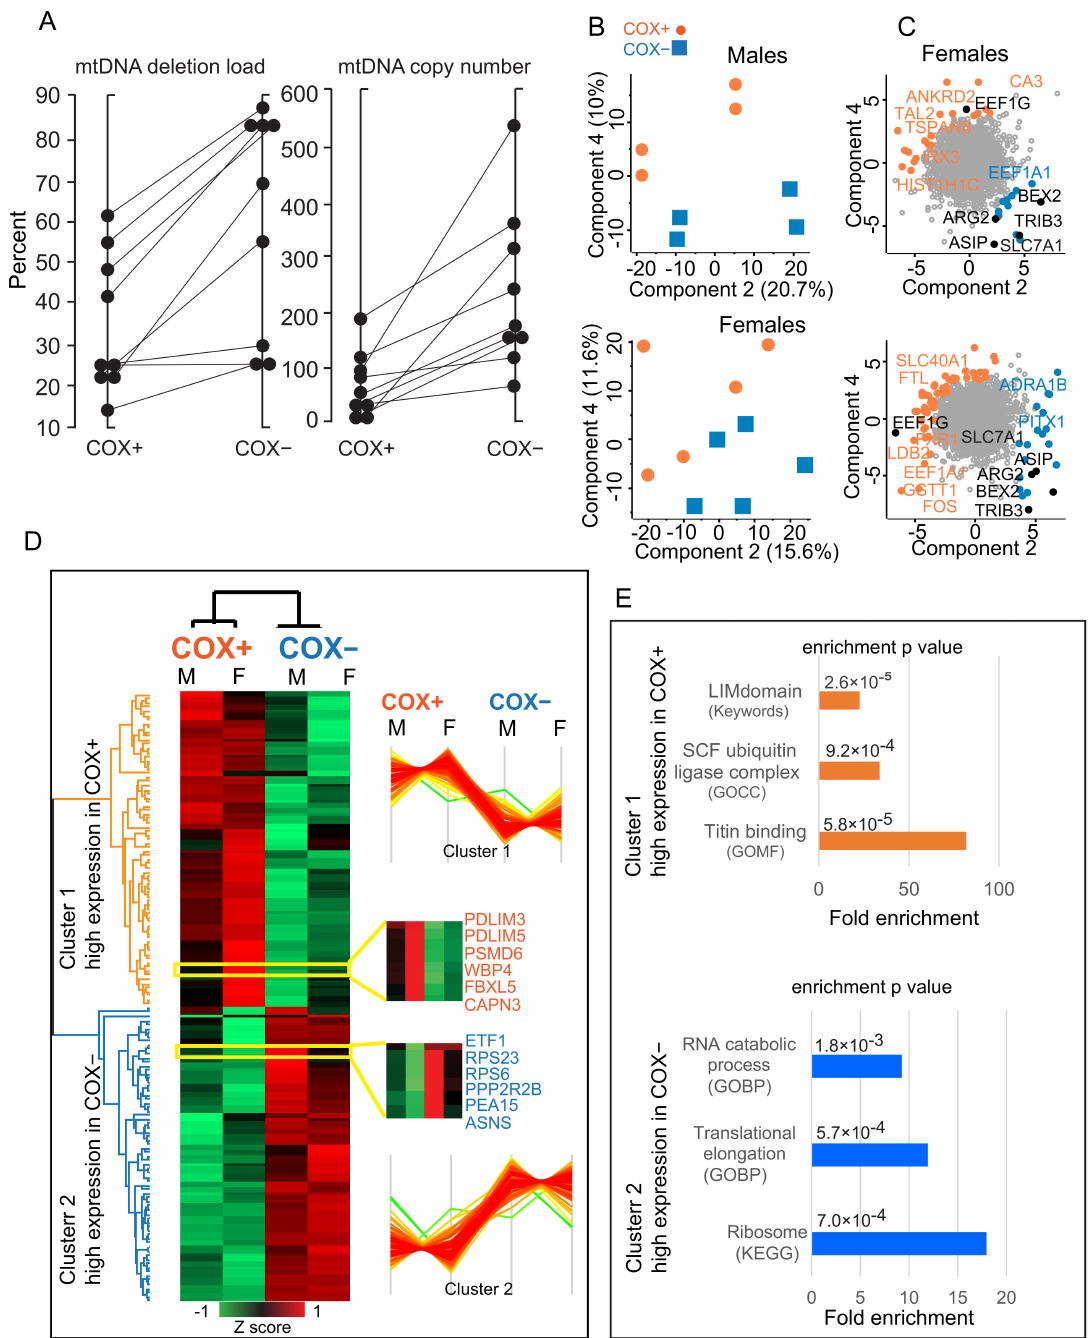
Figure 2. Transcriptomic features of cytochrome oxidase (COX)+ and COX- muscle fibers. ( A ) mtDNA deletion load (%) and copy number (%) of COX-positive (COX+) and COX-negative (COX-) muscle fibers. Each dot represents the value of 500 pooled fiber sections. Fibers isolated from the same biopsy are connected with a line. Average deletion load was COX+ = 35%, COX- = 60% ( p = 0.002). Copy number increased accordingly ( p = 0.007). ( B ) Principal component analysis (PCA) components 2. and 4. COX+ fibers are indicated by orange dots, COX- by blue squares. ( C ) PCA loadings, highlighting the transcripts driving the separation into components being expressed at higher level in COX+ (orange) and COX- (blue) fibers. Top, males. Bottom, females. Loadings which are common hits to both graphs are labeled in black. ( D )